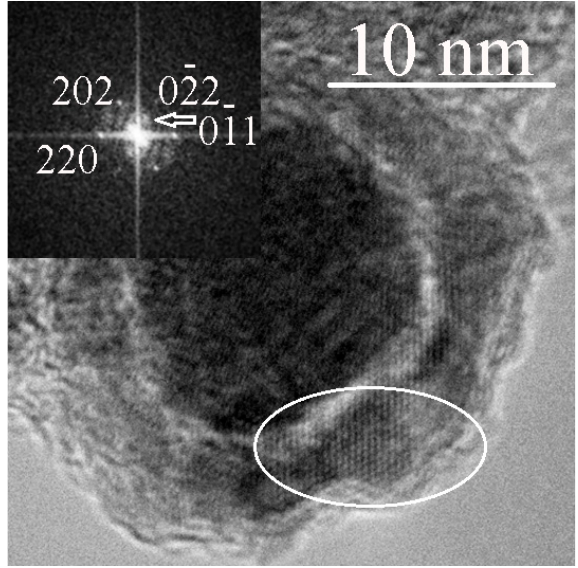
Figure 7. Carbon ‐ encapsulated nanoparticles containing iron; a white ellipse marks a fragment with a γ – Fe 2 O 3 lattice. The tab shows the FFT from the selected area. The presence of reflex (0–11) is characteristic of the maghemite lattice.